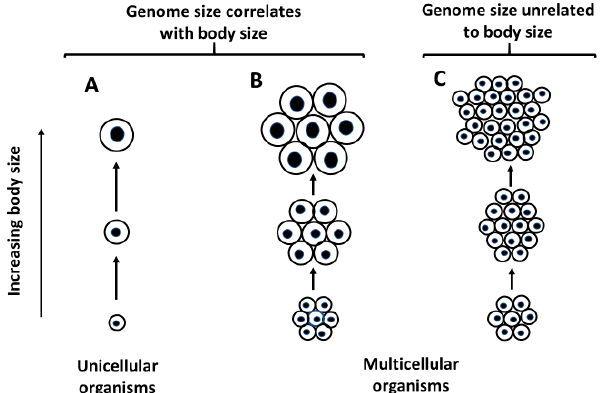
Figure 3. Schematic diagrams illustrating relationships between genome size, cell size and body size in unicellular and multicellular organisms, following predictions #2 and #3 of the Single-Cell ‘Bottleneck’ Hypothesis (SCBH: Table 6). ( A ): Genome size (indicated by the size of the black nucleus in each cell) correlates positively with cell size in unicellular organisms. ( B ): Genome size correlates positively with body size in multicellular organisms that differ largely in cell size. ( C ): Genome size does not correlate with body size in multicellular organisms that differ largely in cell number. Weak correlations between genome size and body size may occur if body size is related to both cell size and number (a situation intermediate between B and C ).